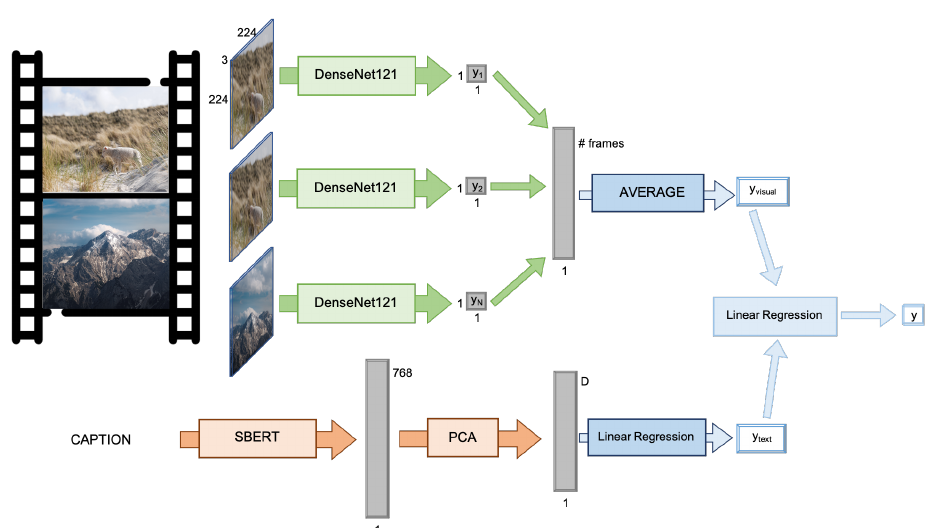
Figure 8. Predictive models used in this study. Visual and text-based branches are combined in a late fusion